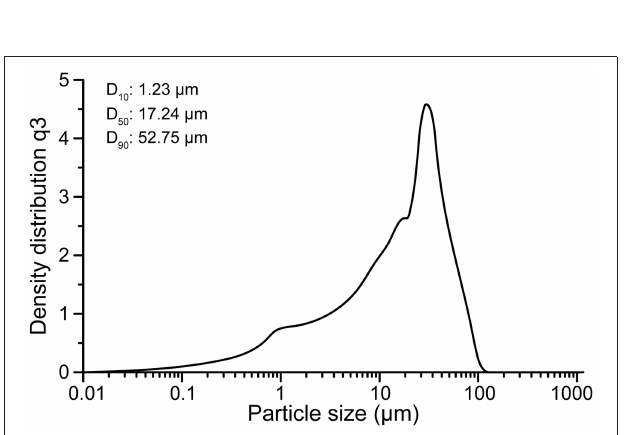
FIGURE 2 | Particle size distributions of the authors’ developed 3D printable geopolymer powder.